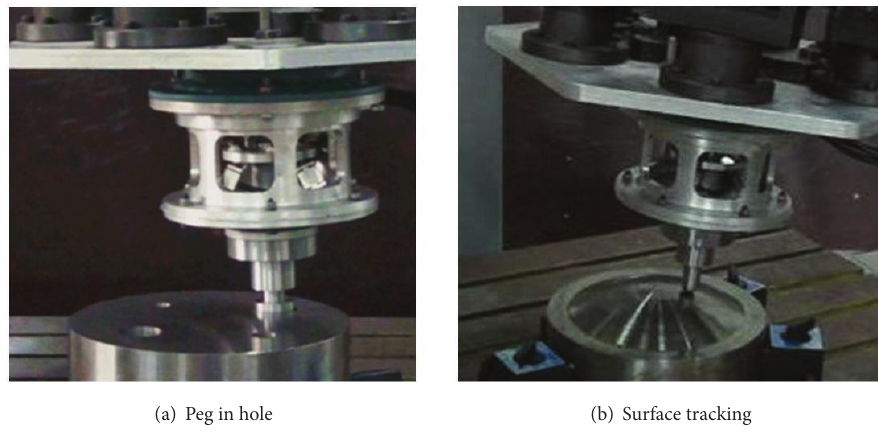
Figure 9: Application of 6PUS-UPU parallel